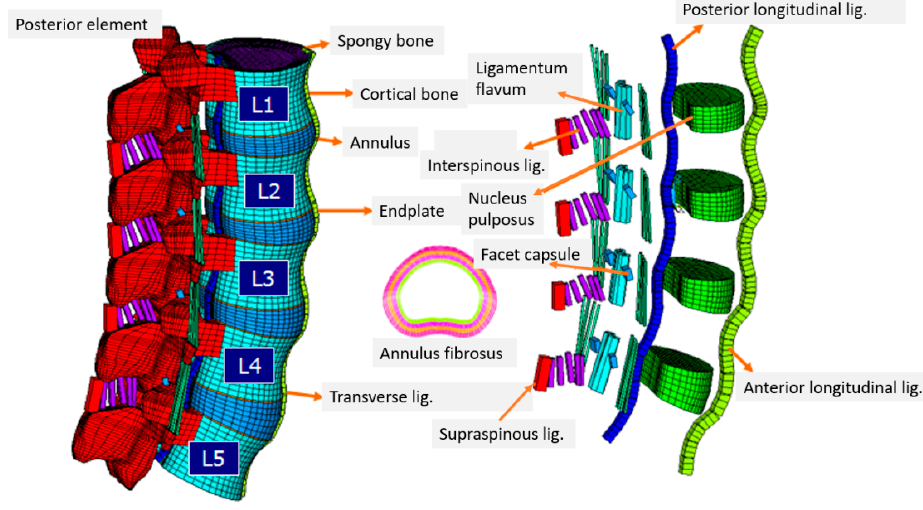
Figure 2. Finite element model of the intact lumbar spine.